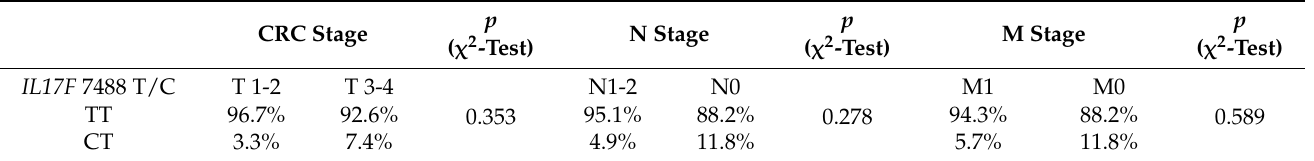
Table 6. The IL17F 7488 T/C SNP was not associated with CRC stage and metastatic status of the patients.